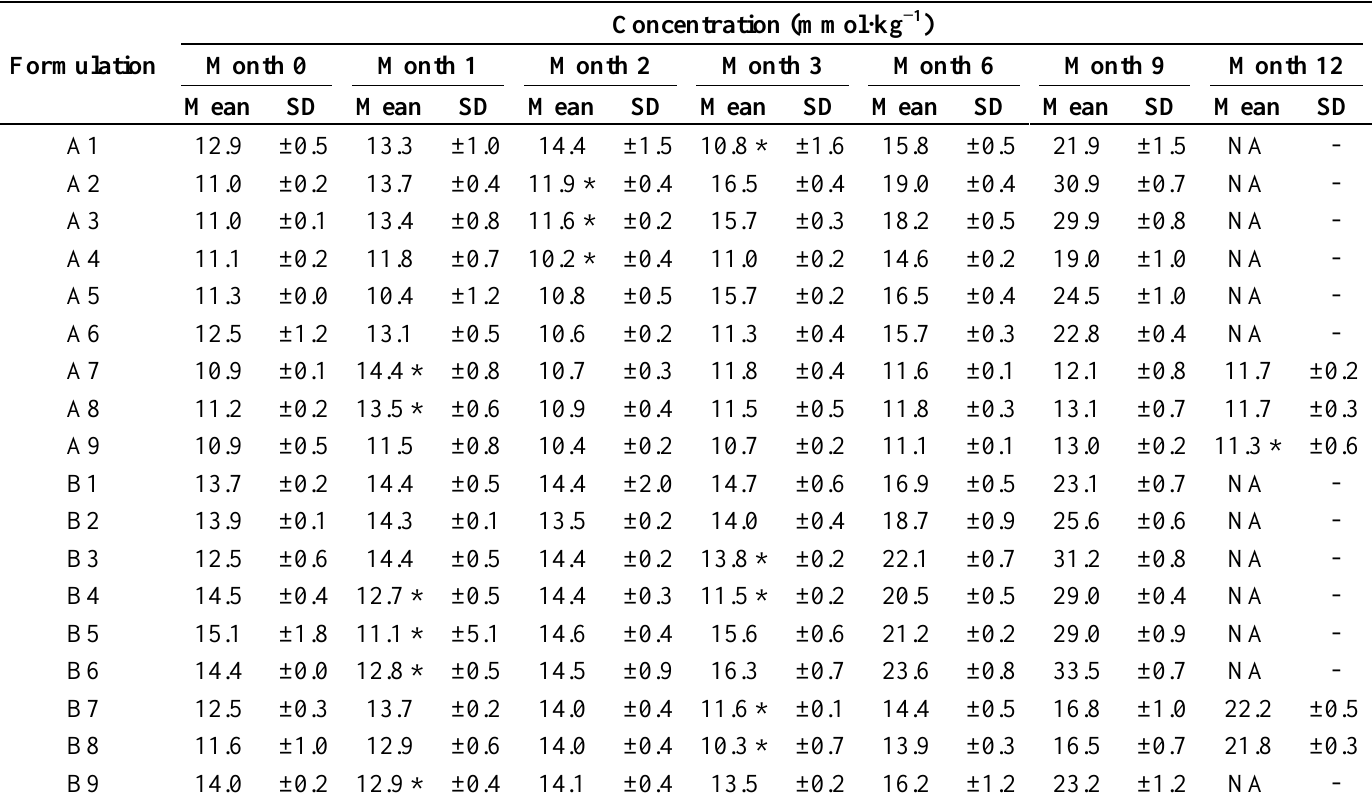
Table 10. Analysis of conjugated dienes in infant formulations with and without antioxidants via UV absorption.